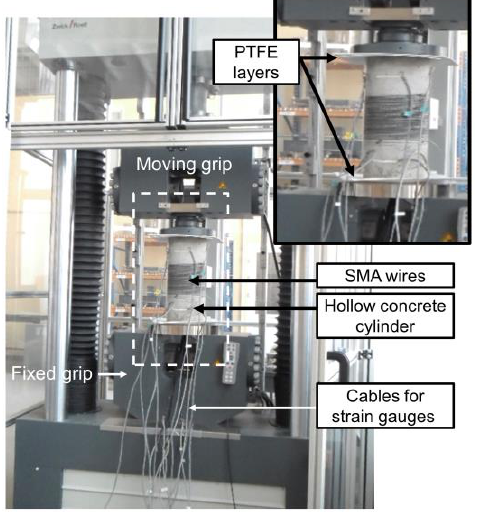
Figure 3. Testing setup.